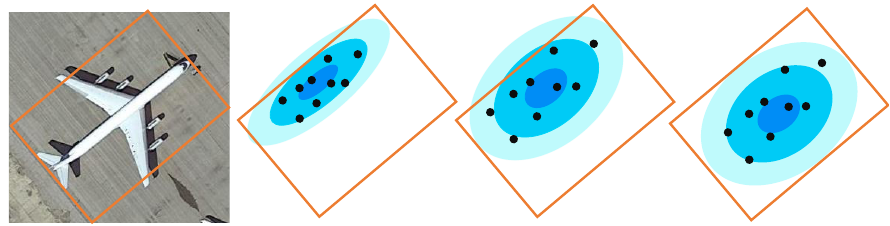
Figure 3. Illustration of the learning process of the Gaussian distribution based on